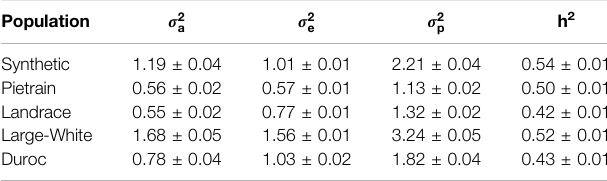
TABLE 3 | Summary of the genetic parameters for backfat evaluated in fi ve pig populations. Population